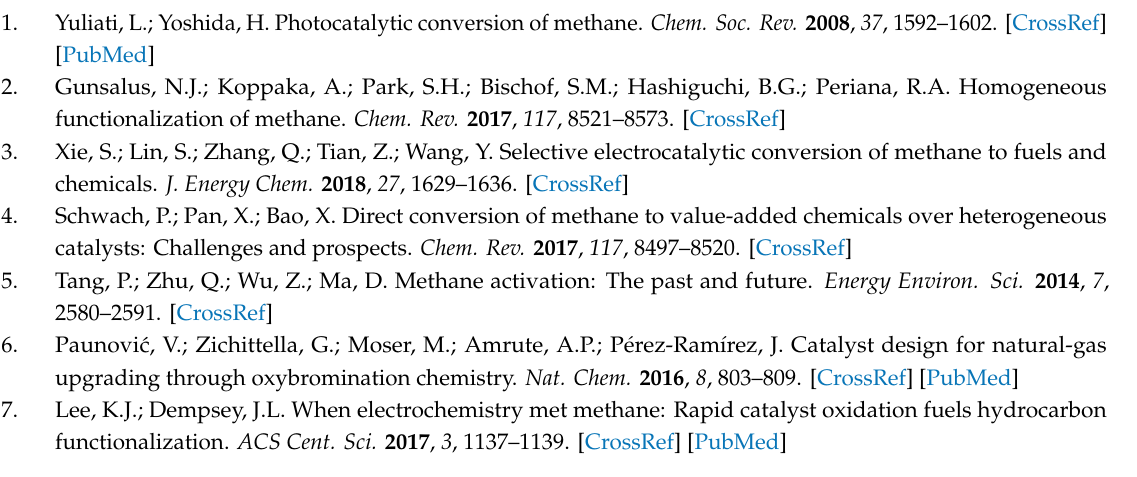
Figure S1: (A) Oxygen signal ( m / z = 32) of mass spectrometry in Ar flow (20 mL / min), and (B) TG curves during the temperature-programmed calcinations of commercial CeO 2 nanoparticles at a heating rate of 5 ◦ C · min − 1 in air and Ar flow (20 mL / min), respectively; Figure S2: Concentrations of oxygen vacancies of CeO 2 -raw and CeO 2 -x; Figure S3: Photocatalytic ethanol conversion to aldehyde over CeO 2 -1100 under simulated sunlight irradiation in pure water. Initial ethanol concentrations were 1.03, 1.54, 2.57, and 3.86 µ mol · L − 1 in the experiments Test1, Test2, Test3, and Test4, respectively; Figure S4: Cycling performances of CH 4 photocatalytic conversion over CeO 2 -1100; Figure S5: The photographs of (A) the methane photocatalytic conversion set-up and (B) the gas-tight glass cell; Table S1: Calculation of quantum e ffi ciency of ethanol production over the catalyst CeO 2 -1100; Table S2: Comparison of the photocatalytic